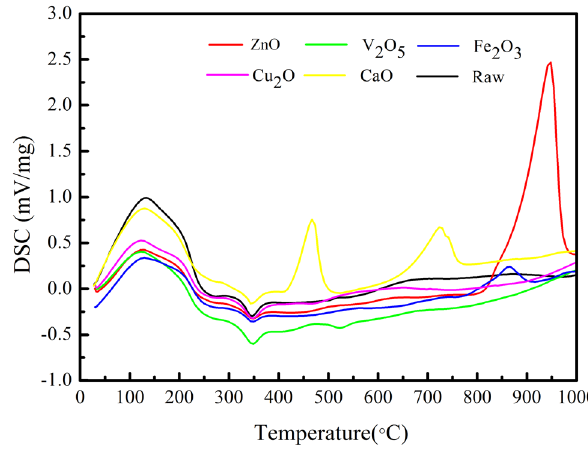
Figure 3: DSC curves of dry navel orange peel for di ff erent metal oxides in argon atmosphere.